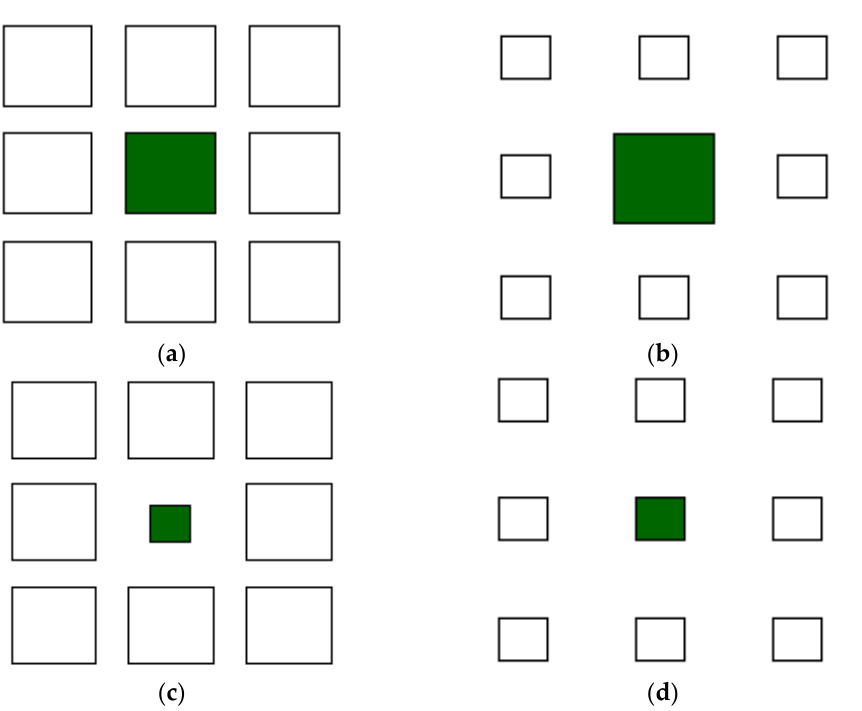
Figure 3. Local Moran’s I for spatial clusters and spatial outliers. ( a ) High–high (HH) spatial cluster, ( b ) high–low (HL) spatial outlier, ( c ) low–high (LH) spatial outlier, and ( d ) low–low (LL) spatial cluster.